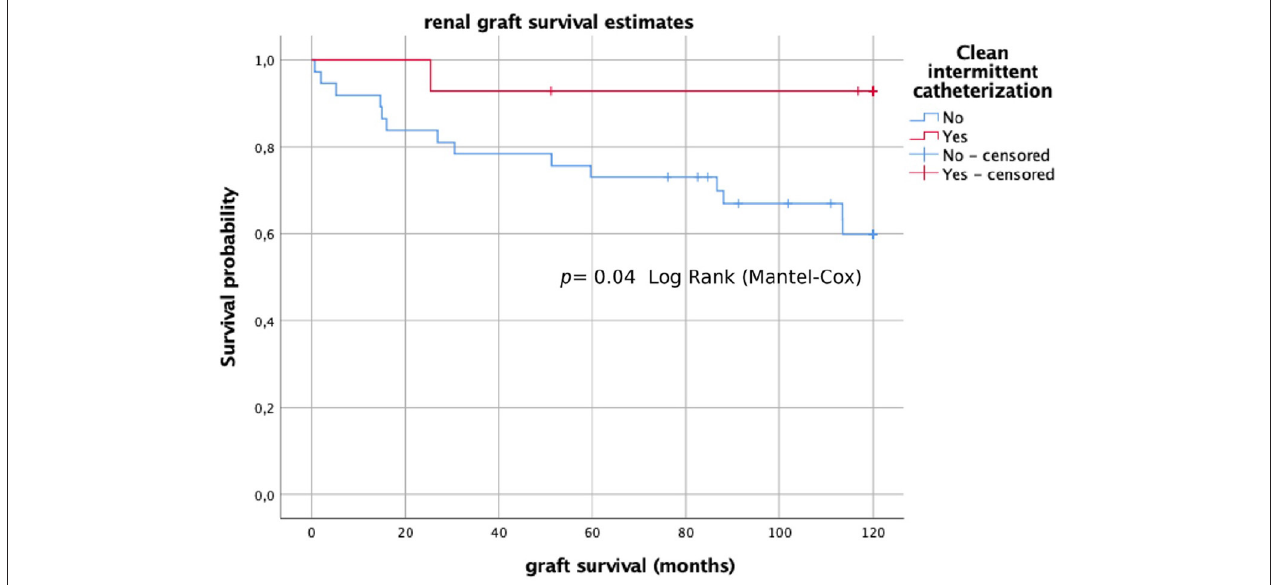
FIGURE 1 | Long-term graft survival (Kaplan–Meier analysis) in patients with CIC and without CIC.